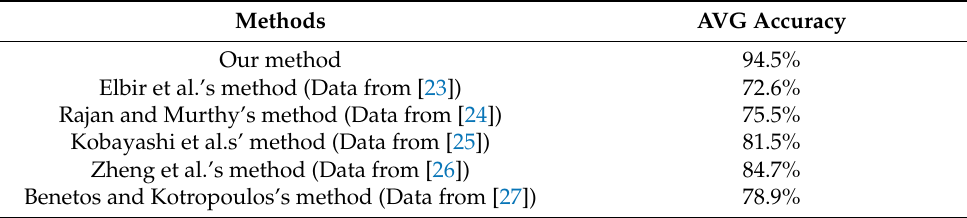
Table 6. Comparison of the proposed method with other methods in AVG